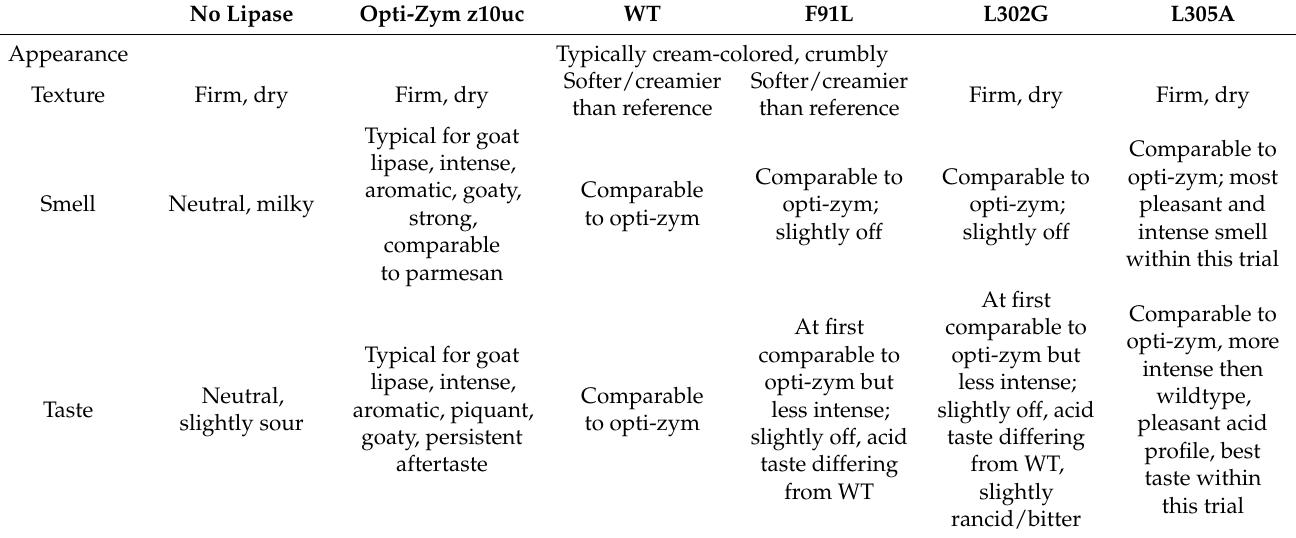
Table 3. Results of the sensory evaluation of different Feta-type brine cheeses produced with the addition of the reference PGE opti-zym z10uc, PCI_Lip WT (1 U), F91L (1 U), L302G (0.7 U), and L305A (1 U) and of a cheese without the addition of lipase after 30 days of ripening. The sensory properties were analyzed by five trained panelists at